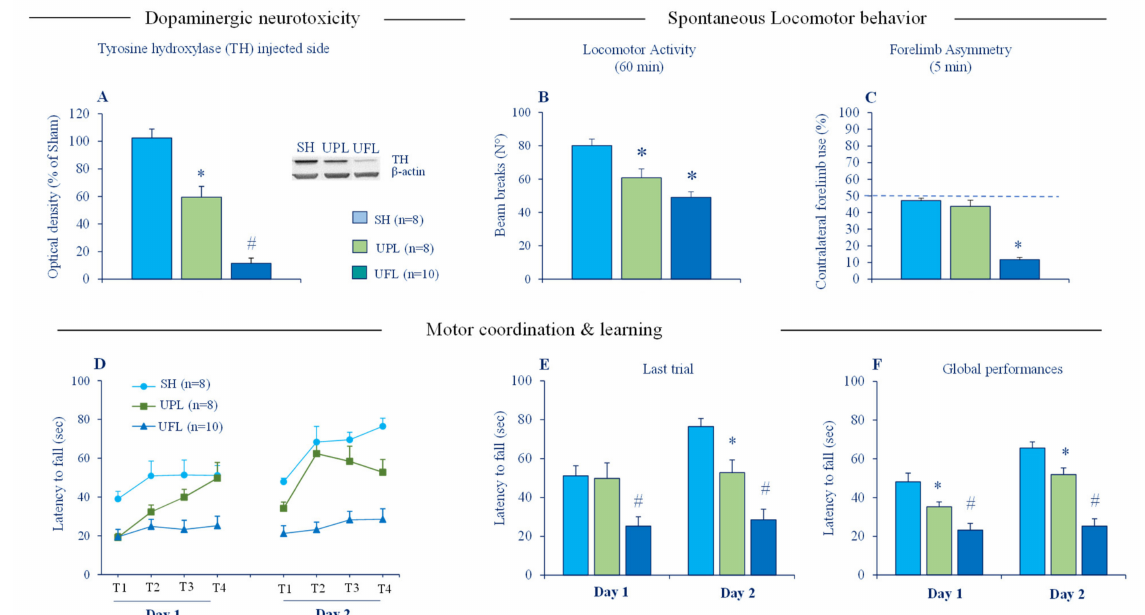
Figure 2. Effects of partial and full unilateral intrastriatal 6-OHDA lesions on striatal tyrosine hydroxylase (TH) protein expression and motor function in C57/BL6 J mice. ( A ) The left panel depicts the densitometric analysis of TH expression in the striatum of WT, unilaterally, partially lesioned (UPL) and unilaterally, fully lesioned (UFL) mice ( n = 8–10 per group); the right panel depicts a representative blot of TH protein in lesioned striatal sides with β -actin as the reference, western blotting analysis were performed in duplicates of the sample. ( B ) Locomotor activity of mice tested in Actimetry cages for 60 min. ( C ) Contralateral forelimb uses of mice tested in cylinder task over 5 min. The dotted line indicates symmetric use of forepaws ( D ) Mean latencies to fall from the rod during training sessions (S1, S2, S3, and S4) in day 1 and 2 in the accelerated rotarod task. ( E ) Mean latencies to fall from the rod in the 4th training session (last session) in day 1 and 2. ( F ) Mean latencies to fall from rotating rod averaged across all sessions in day 1 and 2. SH: sham (non-lesioned) mice, PUL: mice with partial unilateral intrastriatal 6-OHDA lesion and FUL: mice with a full unilateral intrastriatal 6-OHDA lesion. Data expressed as mean ± SEM. * p < 0.05 vs. Sham group, # p < 0.05 vs. all groups, Fisher’s PLSD post-hoc test following a significant one-way